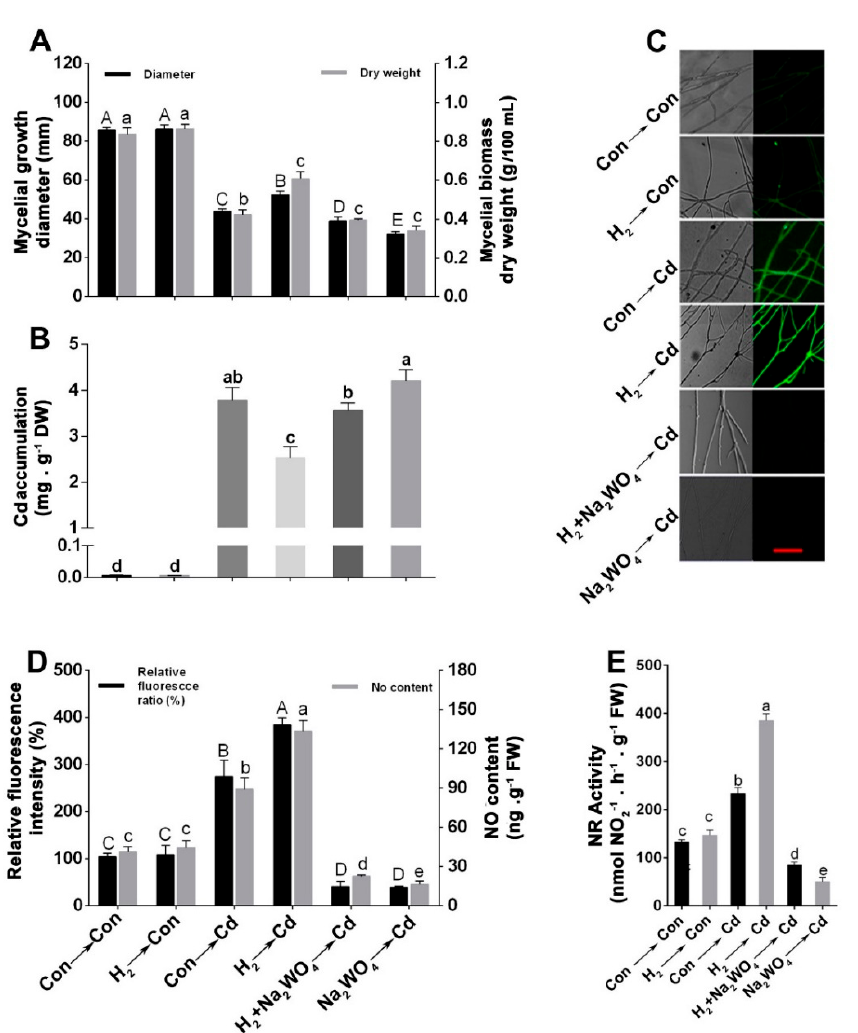
Figure 5. H 2 -induced NO production was sensitive to the NR inhibitor, Na 2 WO 4 . Mycelia were cultured on solid CYM media for 2 days. Then, on the 3rd day, they were either pre-treated or not with 3% H 2 fumigation for 24 h. In all tests of this experiment, stressed mycelia were either treated or not with 500 µ M Na 2 WO 4 for 30 min after H 2 pre-treatment. On the 4th day, 6-mm-diameter mycelial discs were cut from H 2 treated or non-treated mycelia and grown for 8 d on solid CYM with or without 1.75 mM CdCl 2 for growth diameter observation ( A ; left) or liquid CYM with or without 200 µ M CdCl 2 for biomass dry weight detection ( A ; right). Simultaneously, on the 4th day, mycelial discs from H 2 treated or non-treated mycelia were grown for 12 h or 5 days on solid CYM with or without 1.75 mM CdCl 2 . Five-day-stressed or non-stressed mycelia were sampled for Cd accumulation measurement ( B ). Twelve-hour-stressed or non-stressed mycelia were used for NO analysis via confocal laser microscopy ( C ). Scale bar = 100 µ m. The respective fluorescence intensities were measured ( D ; left). Contents of NO were measured by Griess reagent assay as well ( D ; right). Twelve-hour-stressed samples were also sampled for NR activity detection ( E ). Mycelia without chemicals were used as a control for each analysis (Con → Con), while H 2 alone treated mycelia were represented as H 2 → Con. Bars with different letters are significantly different at p < 0.05 according to one-way ANOVA with multiple comparison using Tukey’s test.